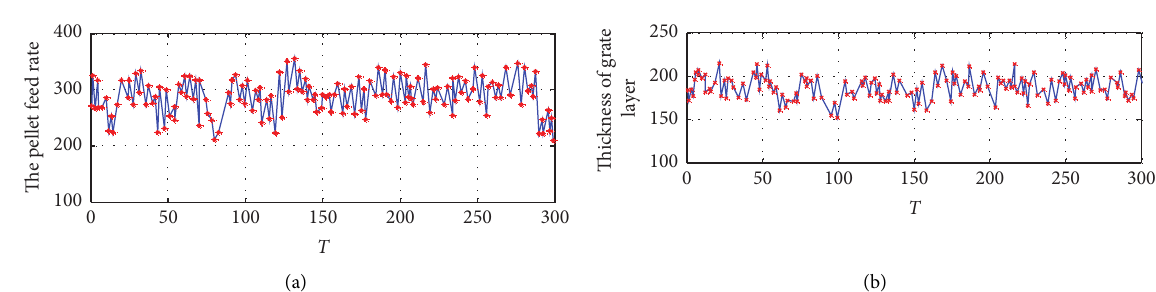
Figure 8: Production data curve of automatic thickness adjustment of chain grate.